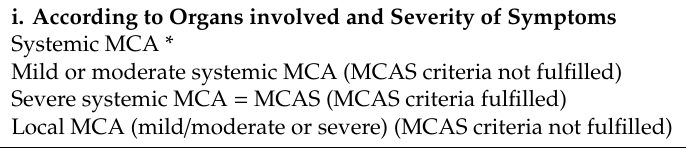
Table 2. Classification of Mast Cell Activation (MCA) and Related